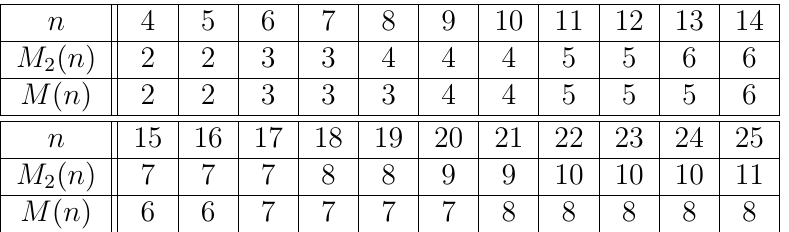
Table 6: Minimum largest term M graphical sequences of length n .